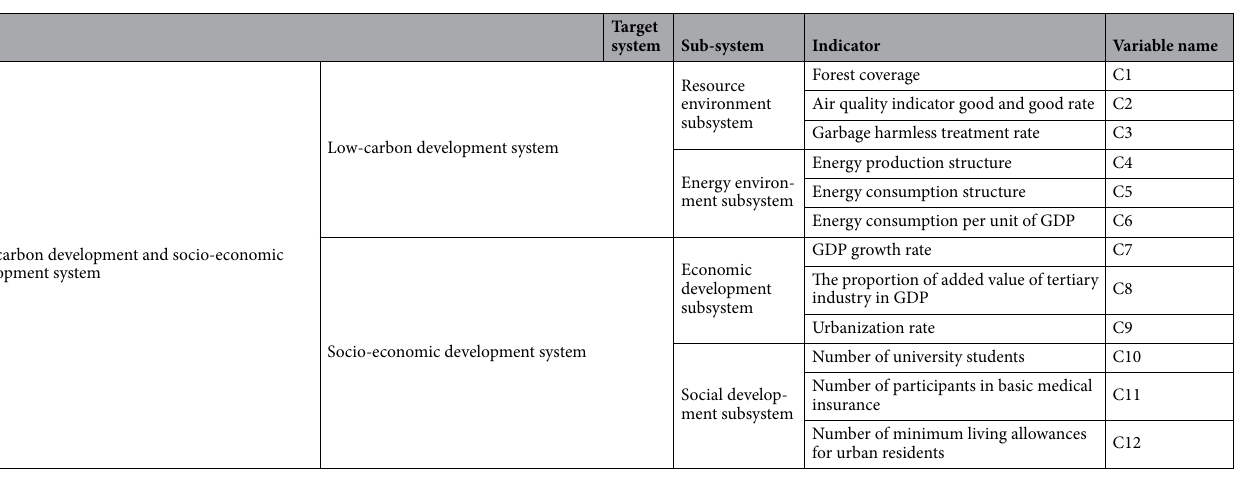
Table 1. Evaluation indicator of composite